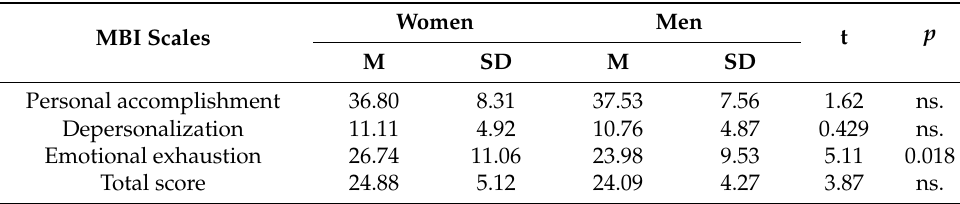
Table 9. Intergender means comparison for burnout (total score and individual subscales).